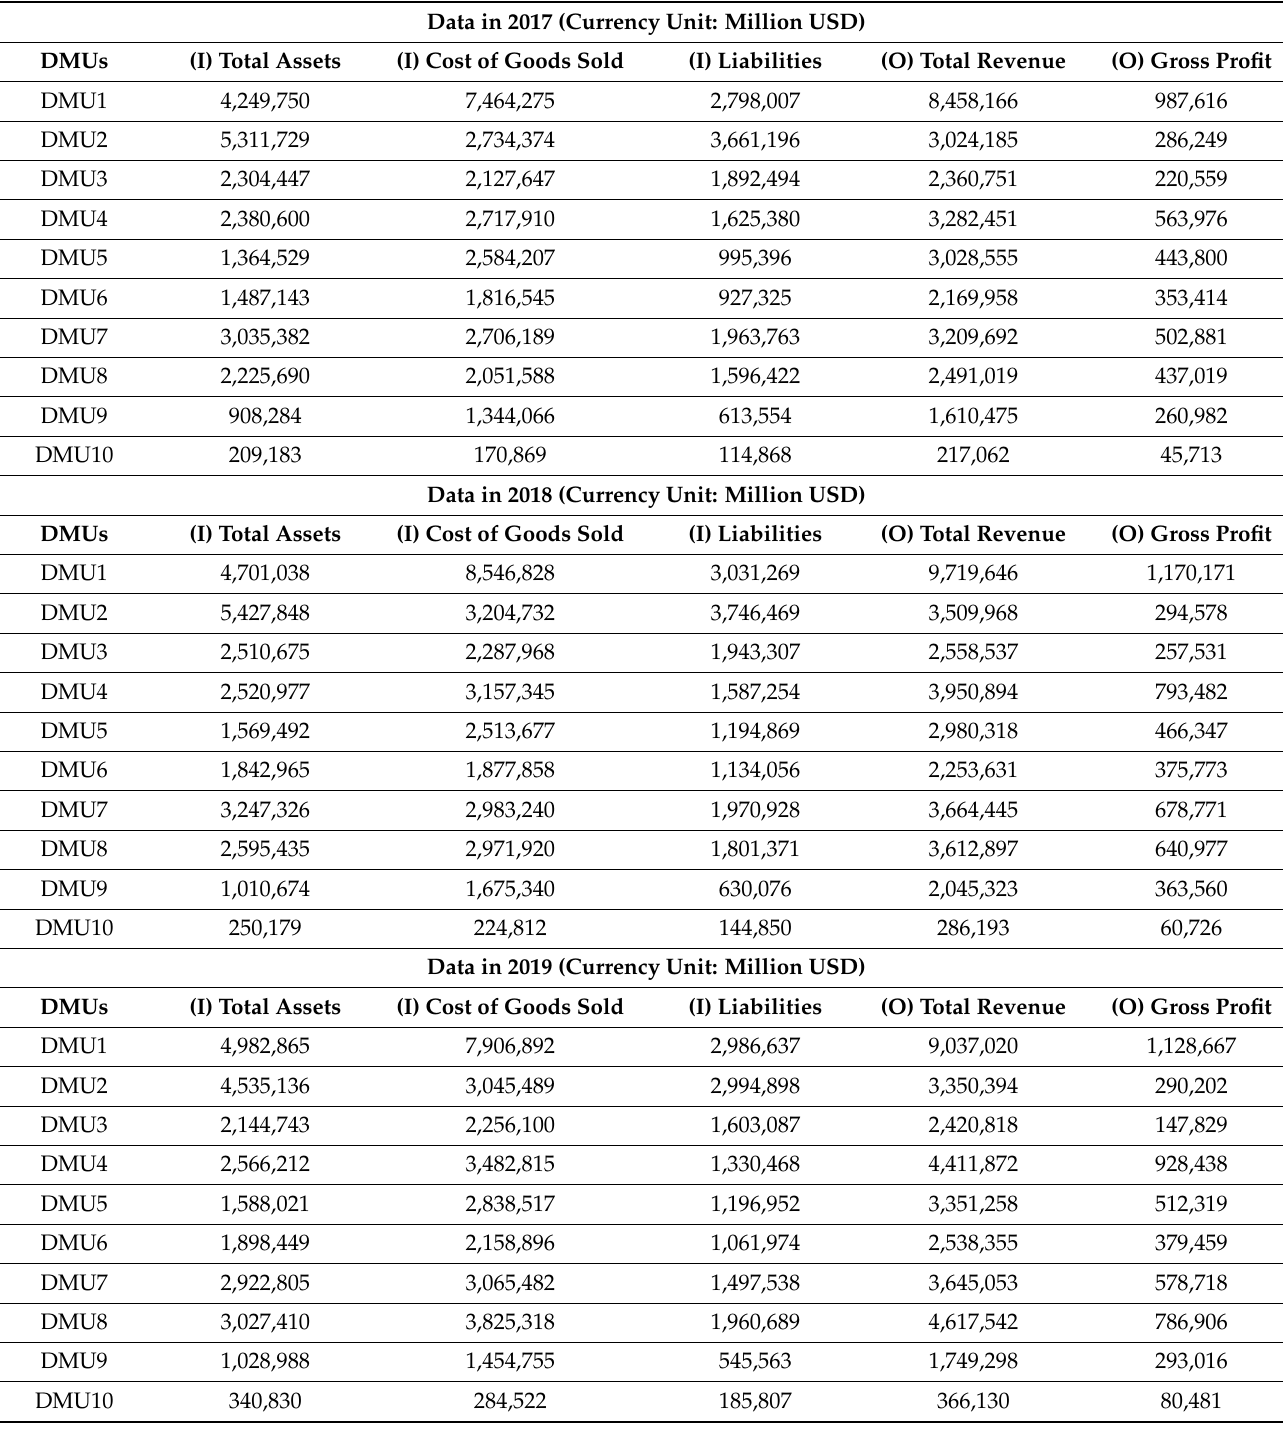
Table 5. The financial results of textile and garment companies in